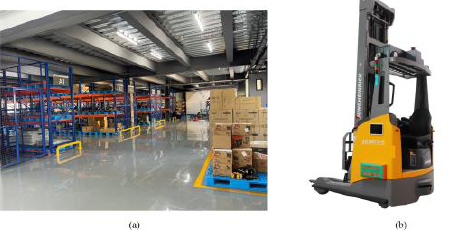
Figure 1. ( a ) FAGV working environment diagram, ( b ) forward-moving FAGV